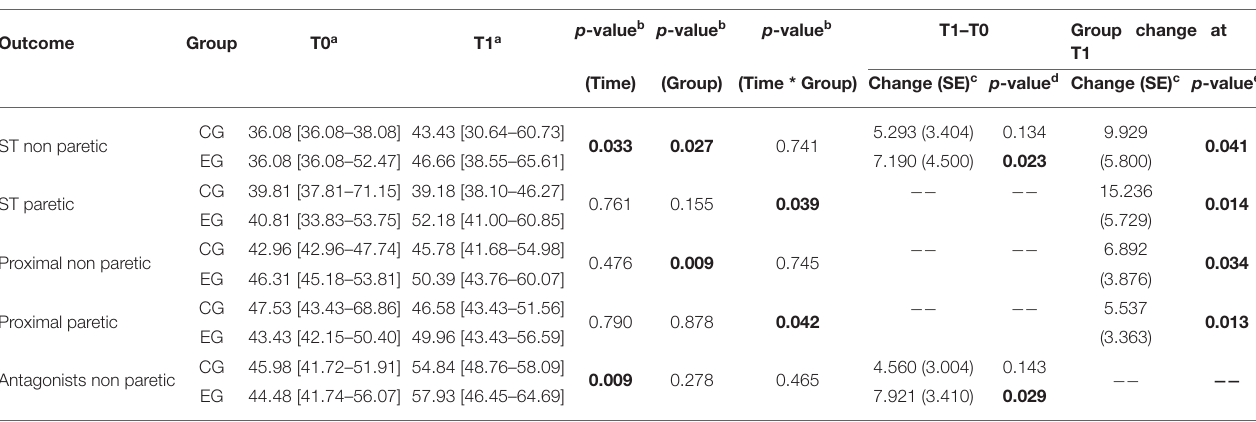
TABLE 4 | Changes over time and between group for burst duration similarity index ( N =